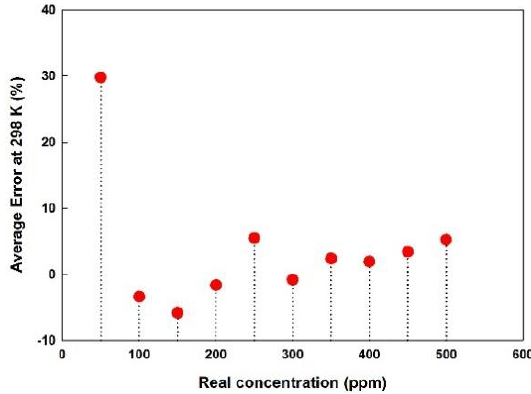
Figure 11. Average error of concentration measurement of Parylene-C module at 298 K.